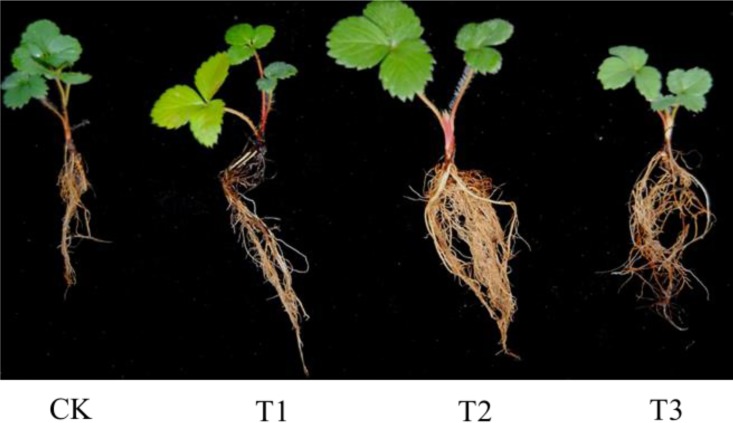
The growth of strawberry seedlings treated with apple fruit fermentation (AFF) plus Bacillus licheniformis after 30 d.(A), the morphological characteristics of the strawberry seedlings. Abbreviation: CK (500 mL water), T1 (AFF 500 times solution), T2 (AFF 500 times solution + 108 cfu/mL Bacillus licheniformis), T3 (108 cfu/mL Bacillus licheniformis).